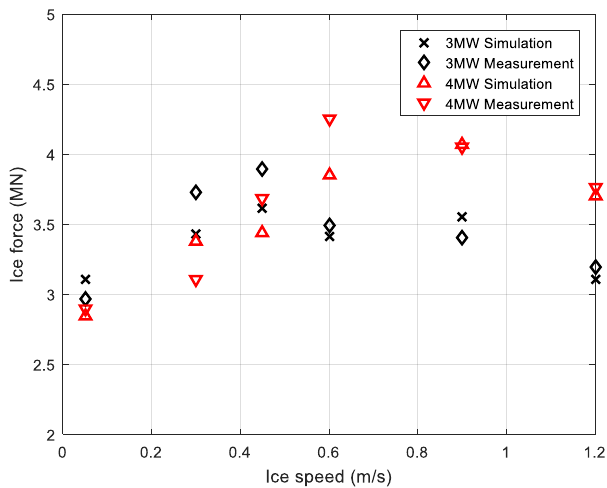
Figure 20. Maximum ice forces from the model test and simulation. Table 8. Statistics for the shape and scale factors for tests 304, 306, 404, and 406 (estimated / Std. error). Simulation Measurement Test No. k